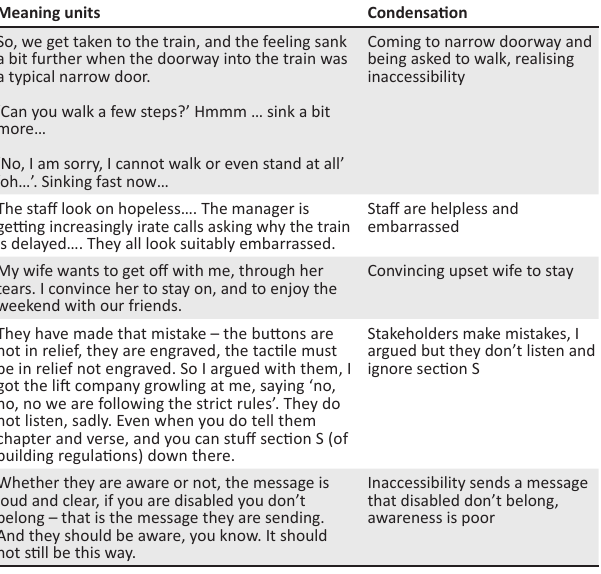
TABLE 2: Meaning units and condensation example (from the experiences of Participant D, male, 47 years old). Meaning units Condensation